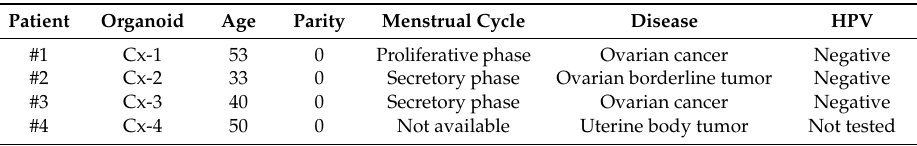
Table 1. Summary of clinicopathological features of the